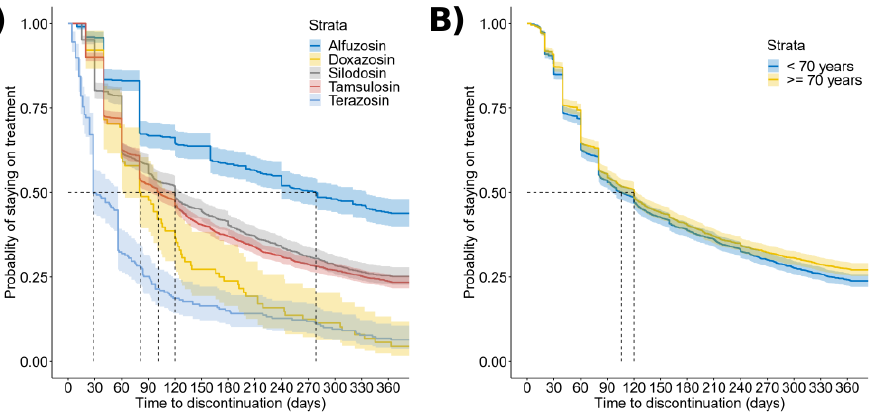
Figure 1. Persistence to treatment with ABs. ( A ) Kaplan-Meier curves of the time to discontinuation for specific drugs (alfuzosin, N = 584; doxazosin, N = 88; silodosin, N = 1074; tamsulosin, N = 2057; terazosin, N = 219); ( B ) Kaplan-Meier curves of the time to discontinuation for younger (<70 years of age, N = 1543) and older (≥70 years of age, N = 1730) men. Table 2. Persistence to ABs and to 5ARIs at 365